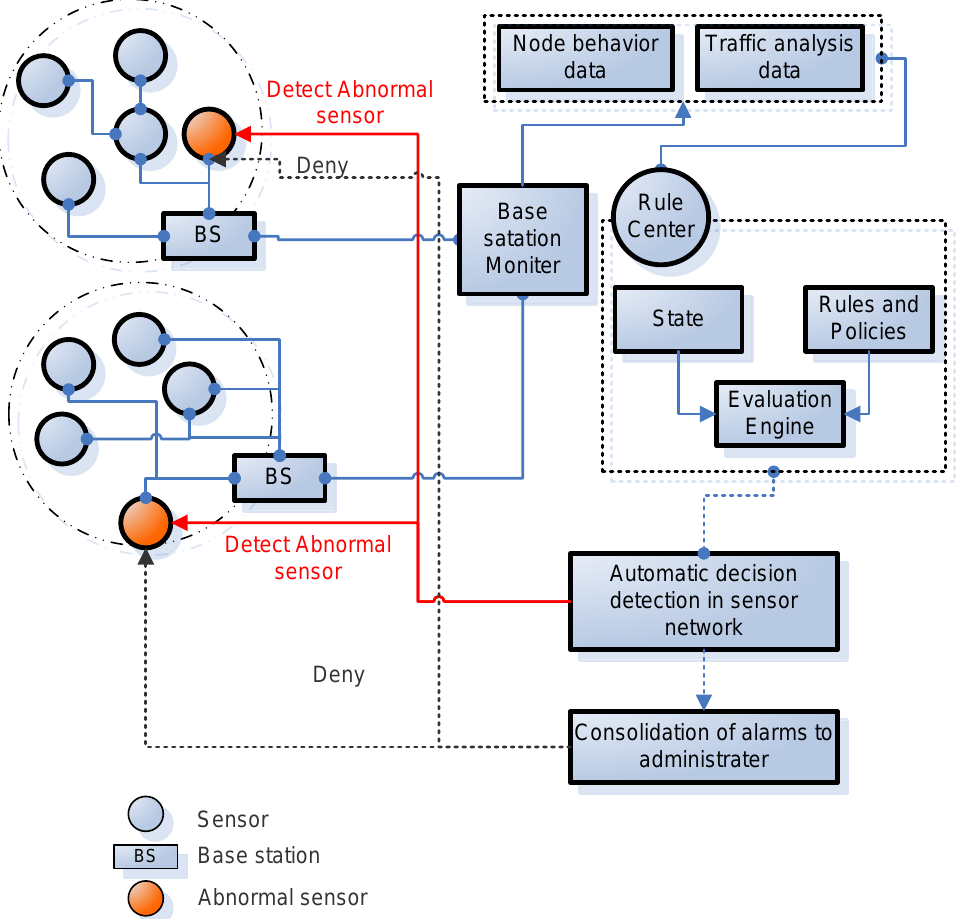
Figure 1. DoS detection system based on global interdependent